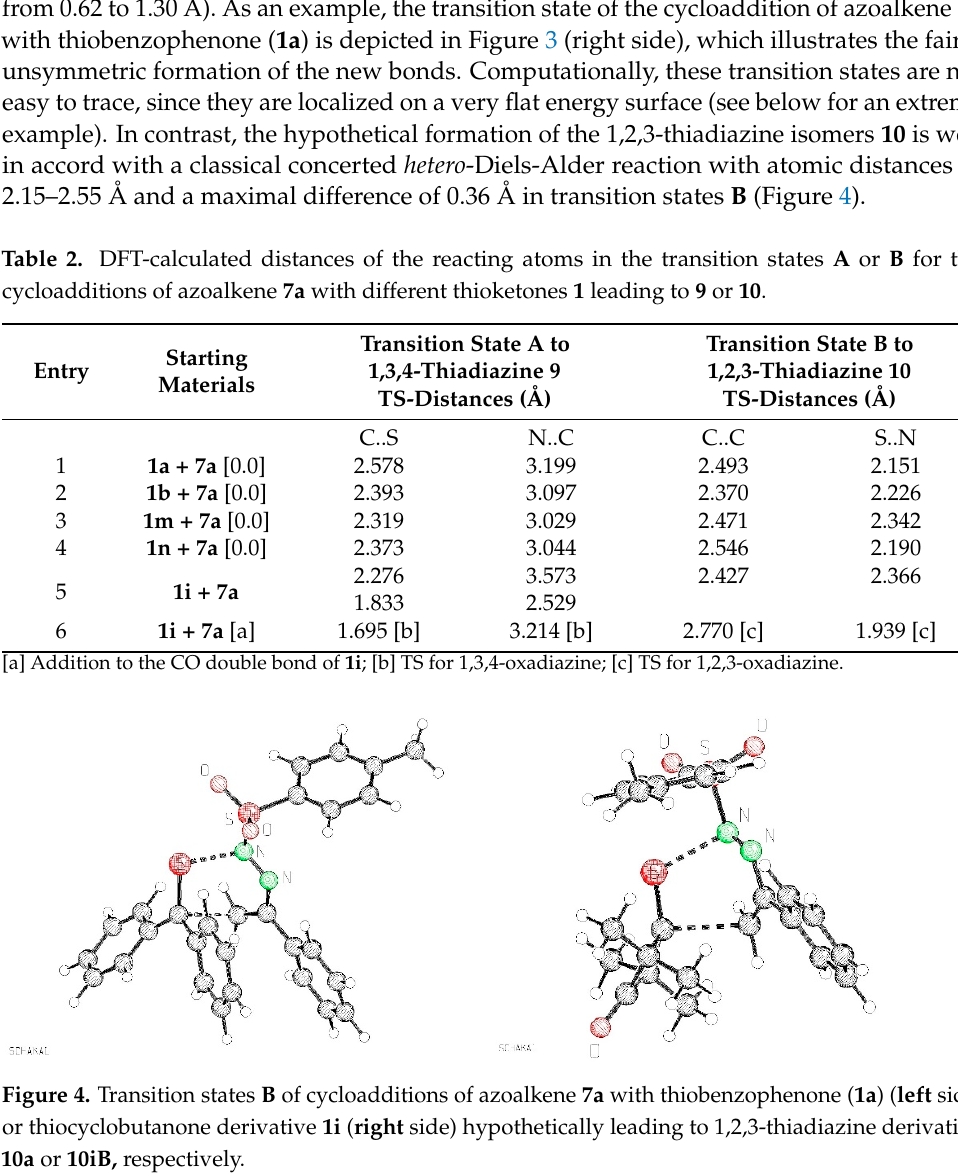
Figure 4. Transition states B of cycloadditions of azoalkene 7a with thiobenzophenone ( 1a ) ( left side) or thiocyclobutanone derivative 1i ( right side) hypothetically leading to 1,2,3-thiadiazine derivative 10a or 10iB, respectively.